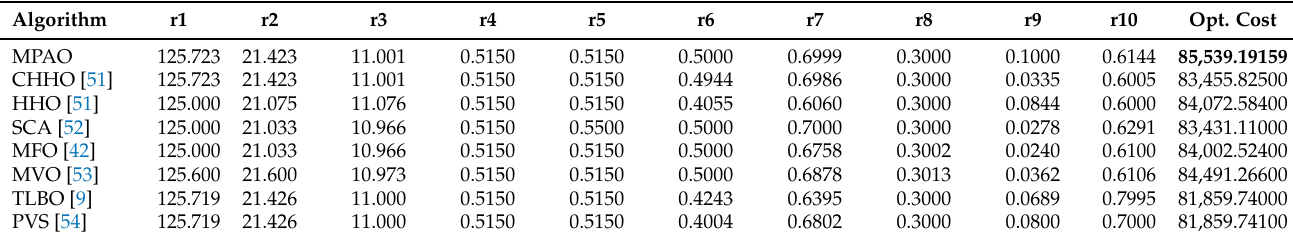
Table 16. Results of the rolling element bearing.